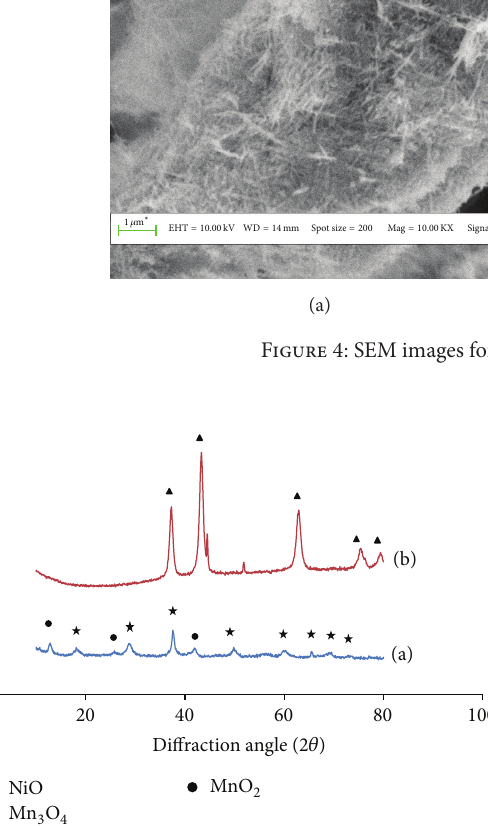
Figure 5: XRD patterns of (a) manganese oxide; (b) nickel oxide.